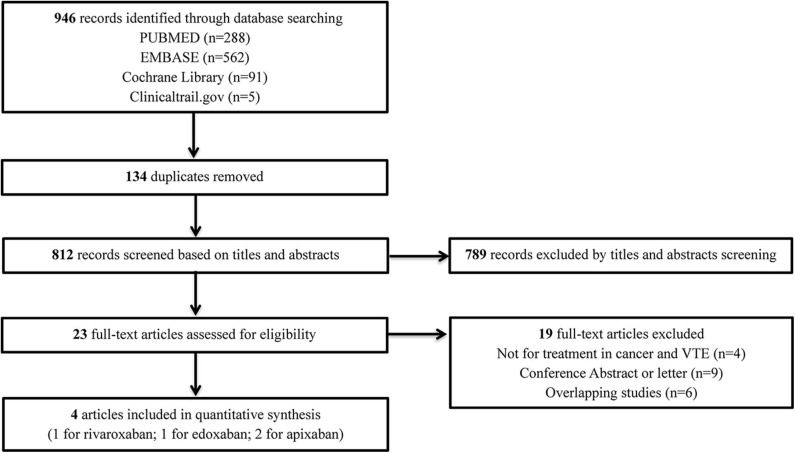
Flow diagram for the selection of eligible studies. VTE, venous thromboembolism.